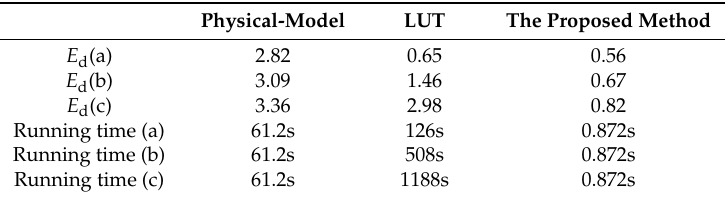
Figure 9. Virtual digital planes of different size corresponding to the three different sampling densities. ( a ) The sampling interval is 300. ( b ) The sampling interval is 600. ( c ) The sampling interval is 900. Table 1. Performance of the three calibration methods with different sampling densities. ( a ), ( b ) and ( c ) respectively represent the different sample density shown in Figure 9.